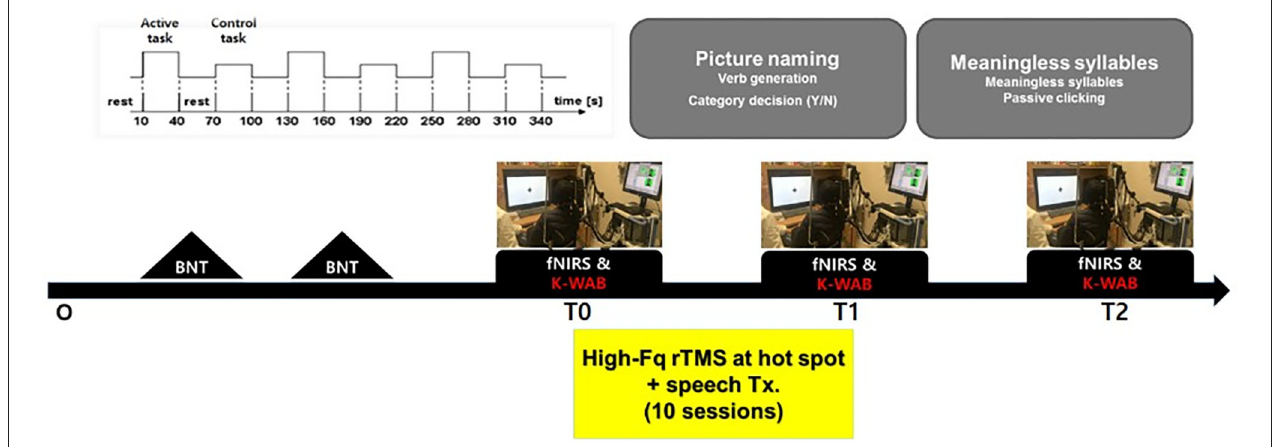
FIGURE 1 | Schematic drawing of the study procedures. BNT, Boston naming test; fNIRS, functional near-IR spectroscopy; K-WAB, Korean version of the Western aphasia